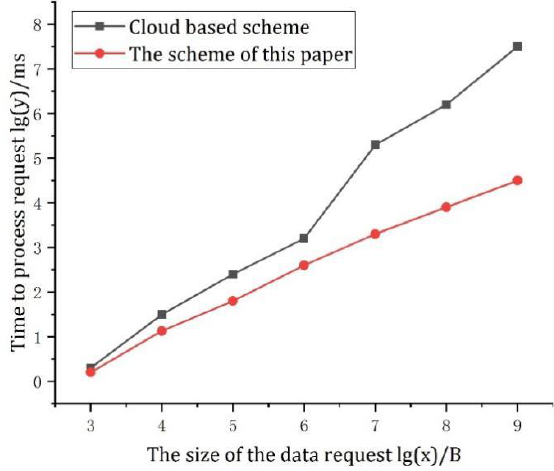
Figure 9. The processing time of the two schemes.